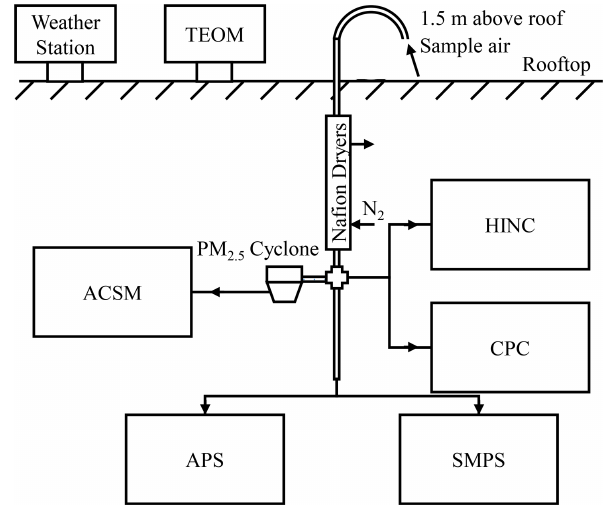
Figure 1. Schematic of the sampling and experimental setup (not drawn to